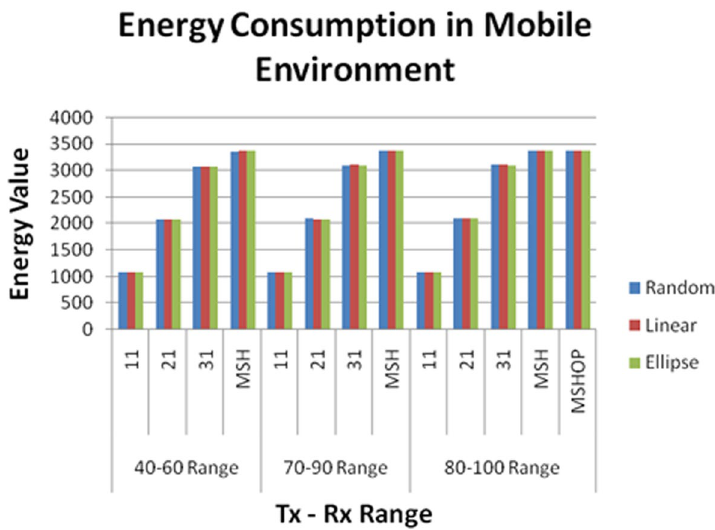
Fig. 32 Total energy in mobile